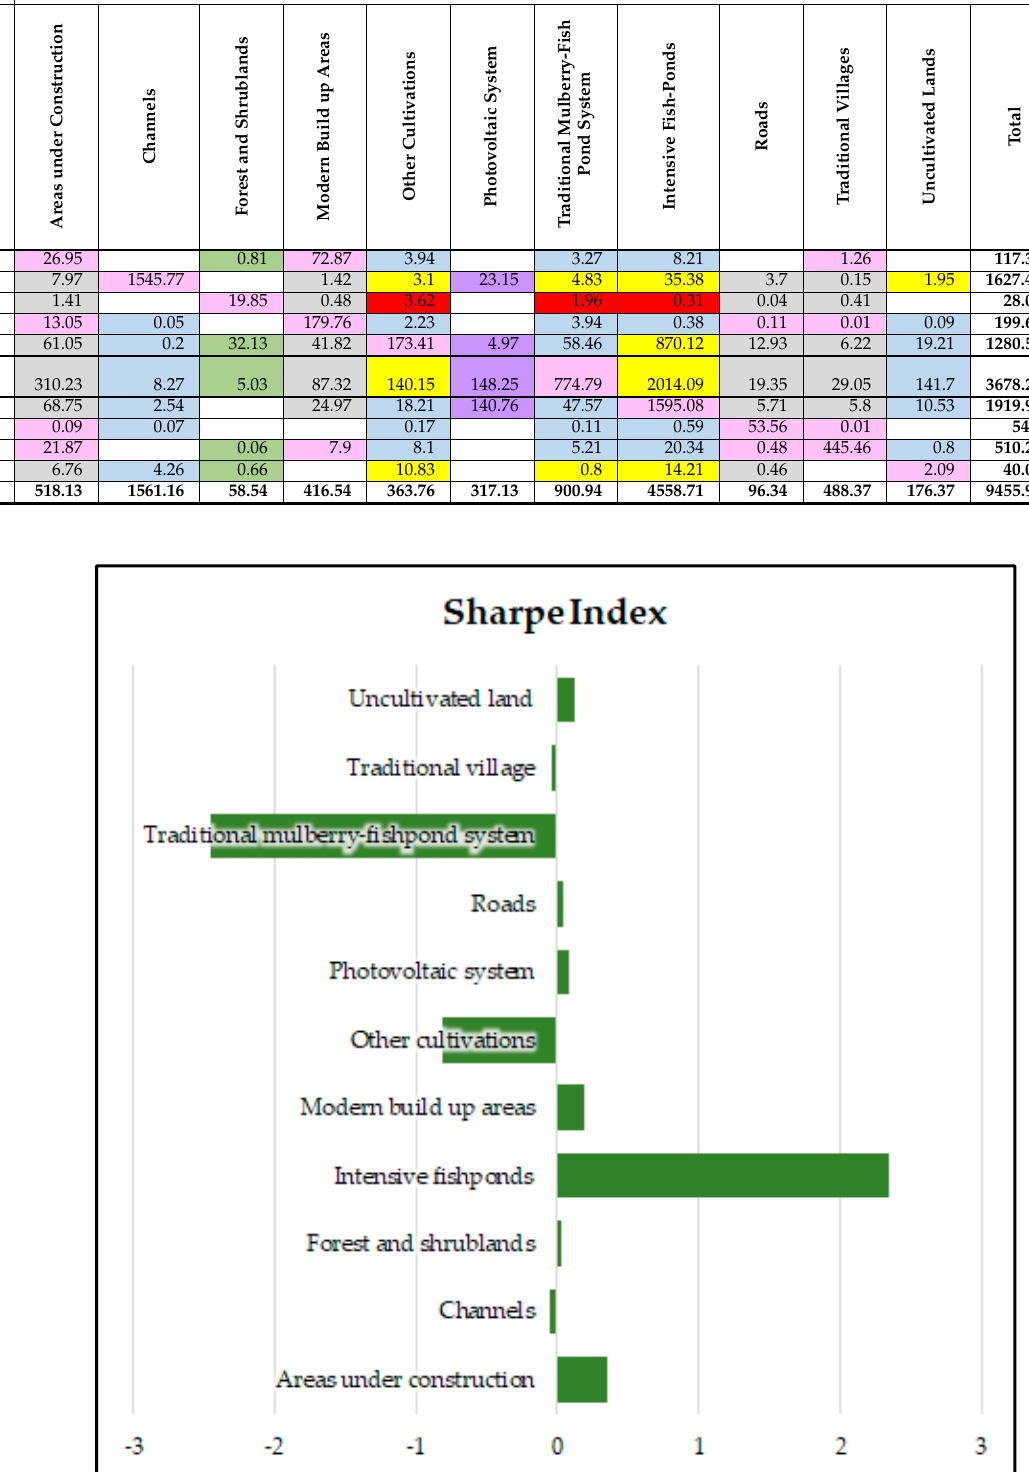
Table 5. Cross-tabulation of land use changes between 2009 and 2021. The colors of the cells are the same of the ones used for the legend of the maps of the land use changes in Figure 5. 2021